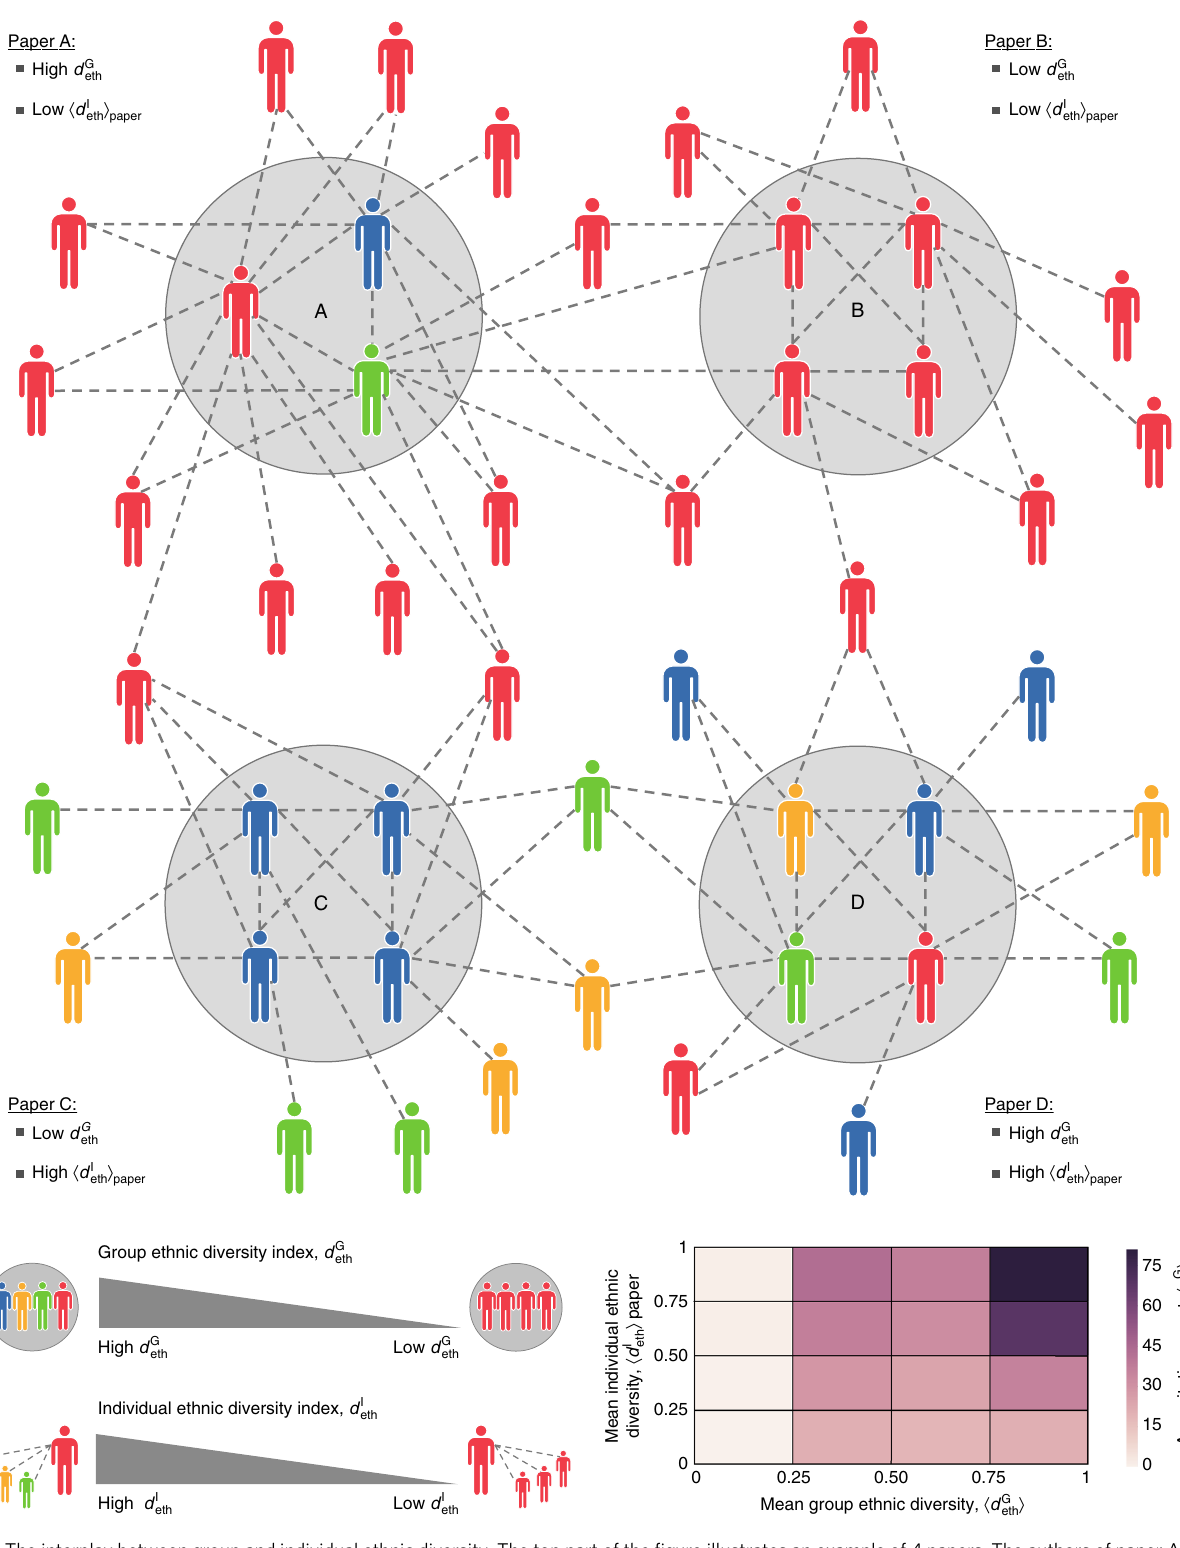
Fig. 5 The interplay between group and individual ethnic diversity. The top part of the fi gure illustrates an example of 4 papers. The authors of paper A have different ethnicities, but each has ethnically homogeneous collaborators. Then, one could argue that paper A has high d G